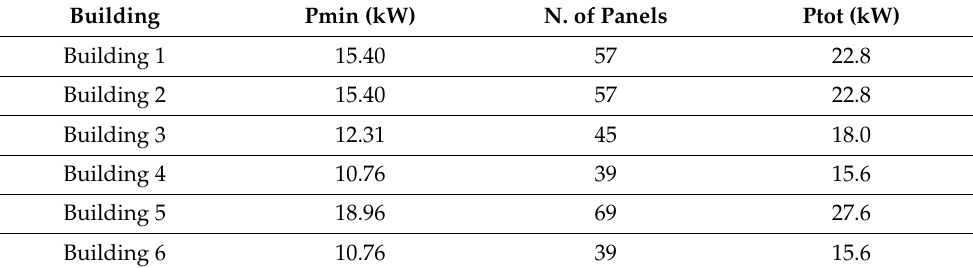
Table 3. Power of the plant.